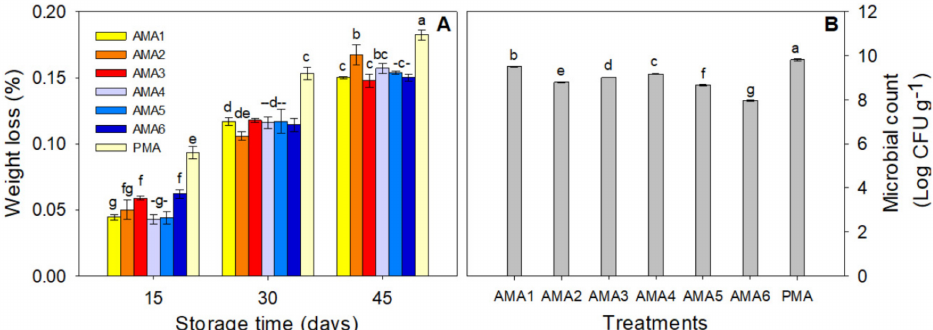
Figure 1. E ff ect of di ff erent active-modified atmosphere packaging (active-MAP) and passive-MAP conditions on weight loss ( A ) through the 45 days of storage, and microbial counts ( B ) at the end of storageoffreshin-hullpistachiosstoredat4 ± 1 ◦ Cand90 ± 5%relativehumidity(R.H.). Meansfollowed by the same letter for a parameter, are not significantly di ff erent by least significant di ff erences (LSD) ( p ≤ 0.05). Vertical bars indicate the standard errors of four replicates.